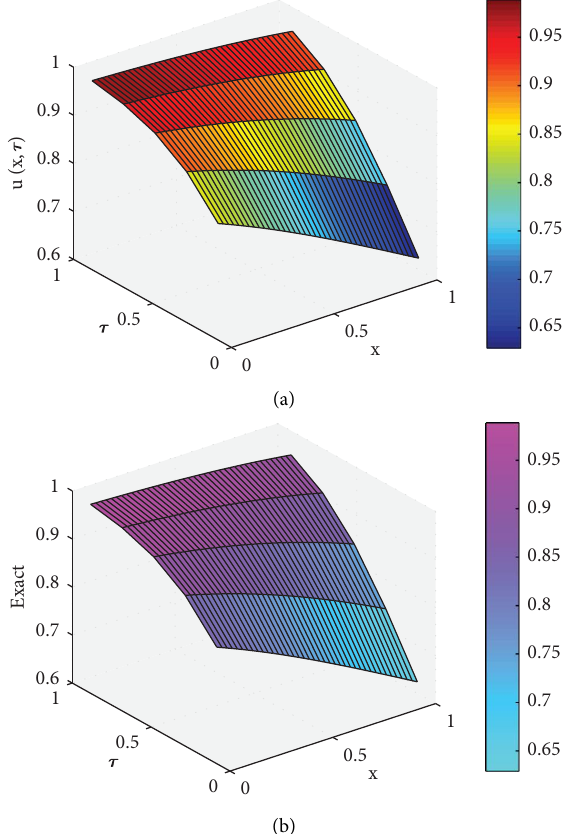
Figure 8: (a) Approximate solution and (b) exact solution of Example 3.